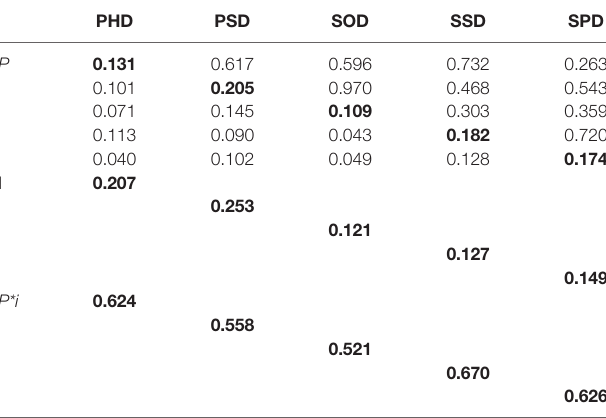
TABLE 4 | Estimation of variance and covariance components in various domains in the p (cid:129) × i ° -designed G-study ( n = 246). PHD PSD SOD